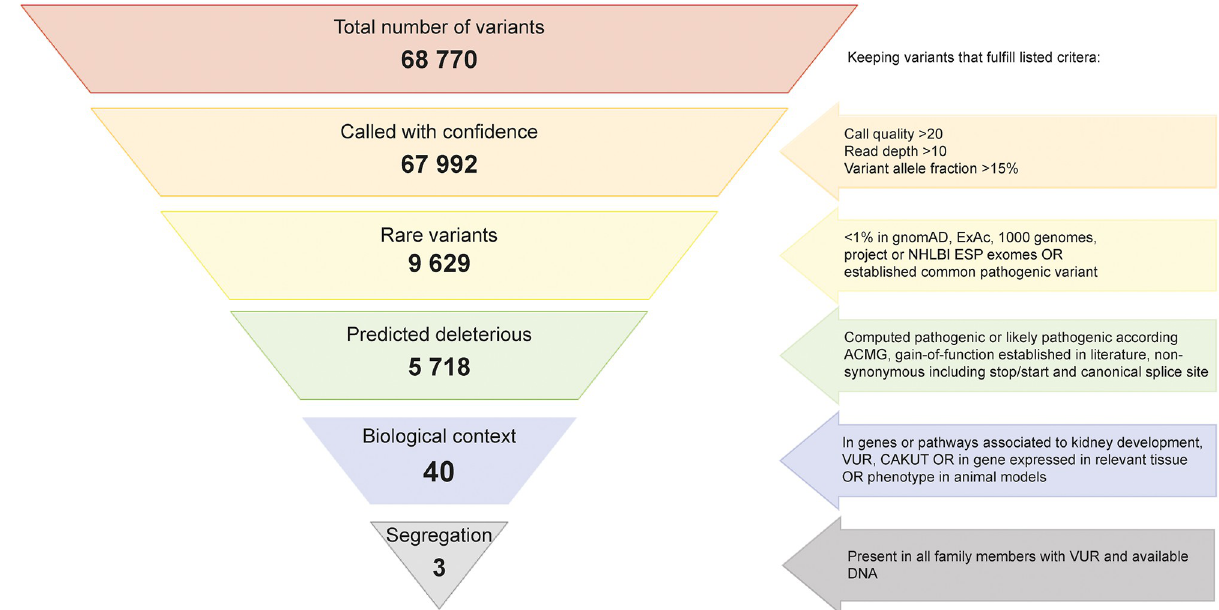
Fig 3. Filtering of called variants. Systematic filtering of single nucleotide variants called from CLC workbench with number of variants remaining after each step and criteria for retaining variant as indicated. Sanger sequencing